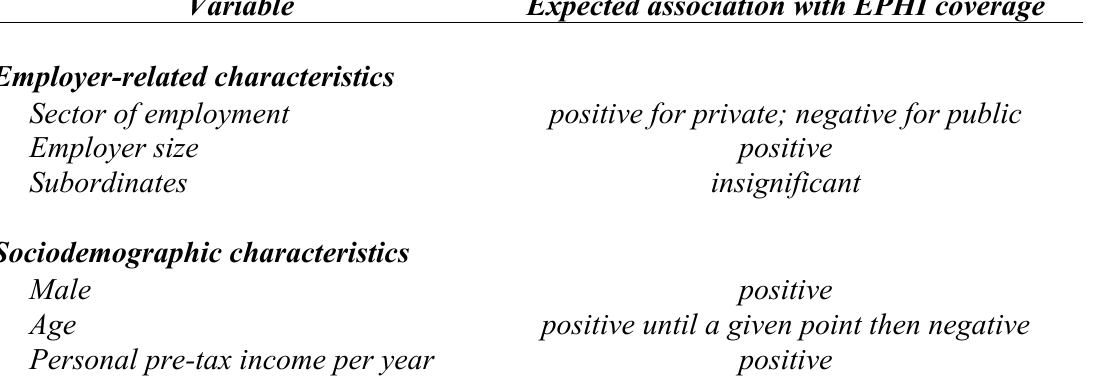
Hypotheses for potential determinants Variable Expected association with EPHI